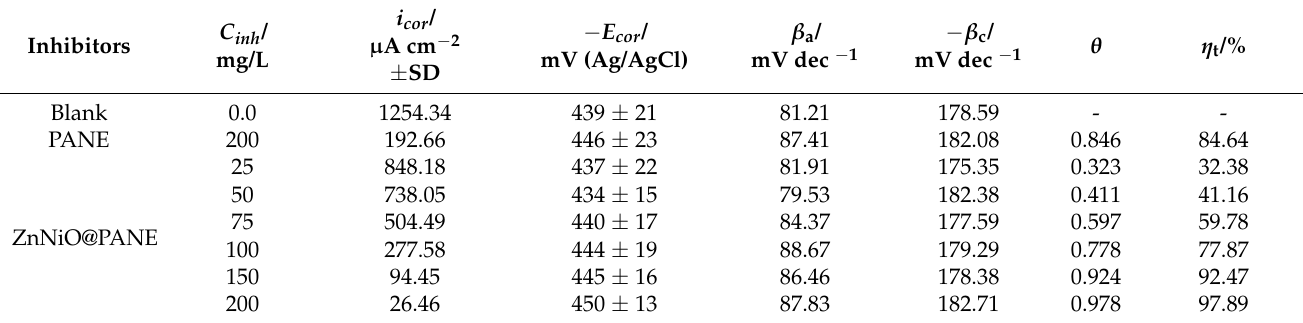
Table 1. Potentiodynamic restrictions of MS-alloy corrosion in the blank HCl-containing brine solution and with the addition of different doses of ZnNiO@PANE at 298